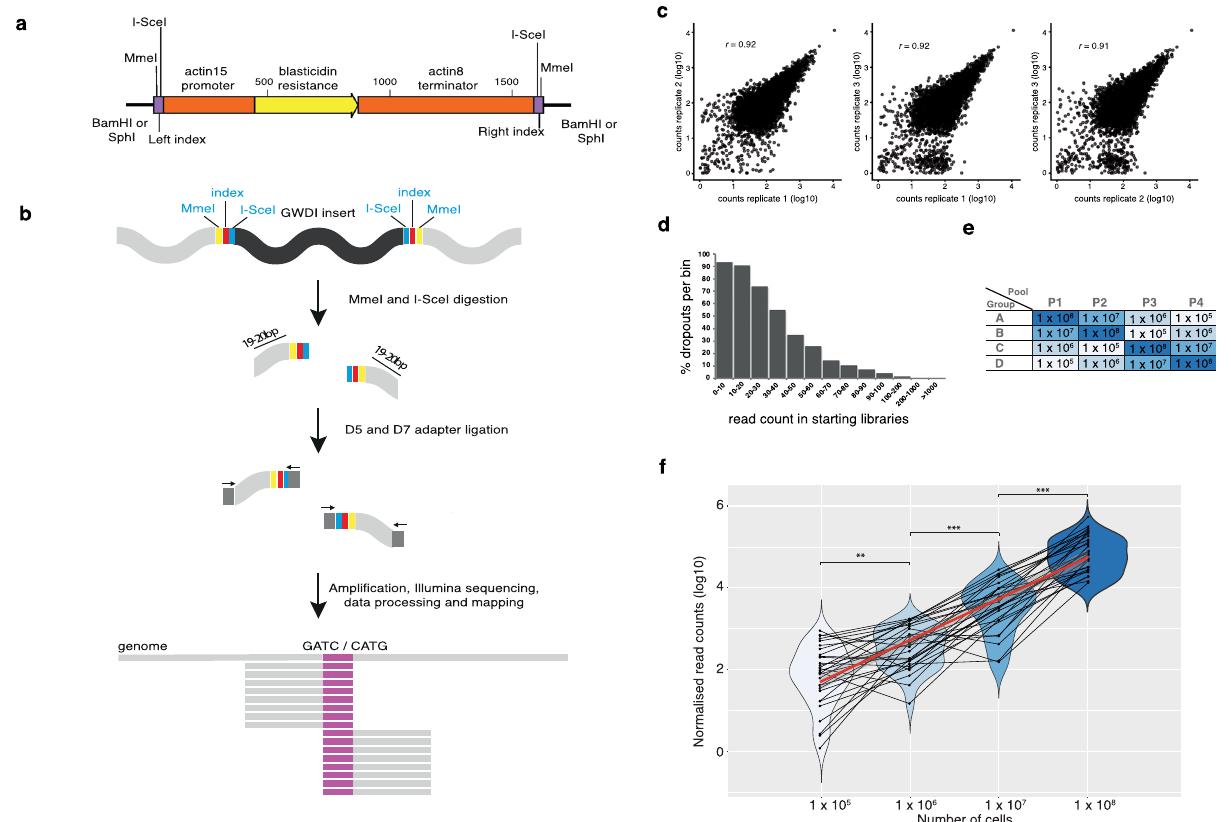
Fig. 3 REMI-seq can be used to quantify the relative abundance of mutants. a Schematic of ampli fi ed insert for REMI mutagenesis. The insert was PCR ampli fi ed from the pGWDI plasmid 37 . b The REMI-seq method for insertion point identi fi cation. The GWDI fragment containing a blasticidin resistance cassette (black) inserts into the D. discoideum genome at DpnII or NlaIII loci. The termini of the GWDI insertion fragment contain recognition sequences for the type II restriction enzyme MmeI (yellow) and the meganuclease I-Sce I (blue). Digestion with Mme I and I-Sce I results in the generation of two 47 – 48 bp fragments. These fragments can be enriched by PCR and gel extraction, thus allowing identi fi cation of 19/20 bp of genomic sequence at the site of insertion by sequencing. c REMI-seq exhibits high technical reproducibility. Three preparations of gDNA from a pool of ~13,000 mutants were sequenced. Normalised read counts for each mutant are highly correlated across each replicate ( r = 0.92; r = 0.92; r = 0.91, p < 2.2 ×10 − 16 for all comparisons). d Technical reproducibility and dropout rate is dependent on read count. Mutants were divided into bins dependent on the average starting read count between all replicates of the starting library. The percentage of mutants that could not be detected (dropped out) in one or more library was calculated for each bin. e Schematic of the experiment to determine the quantitative dynamic range of REMI-seq. Cells of 32 de fi ned mutants were distributed into four groups (A, B, C, D) of eight mutants each (Supplementary Data 1). 10 5 , 10 6 , 10 7 , or 10 8 mutant cells from each group were mixed to form four